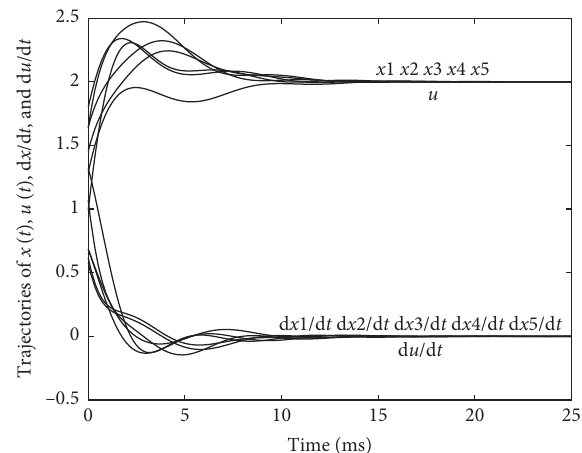
Figure 1: Transient behavior of x ( t ) and u ( t ) of the second-order differential equation system (16) in the example with ρ � 0 . 1.